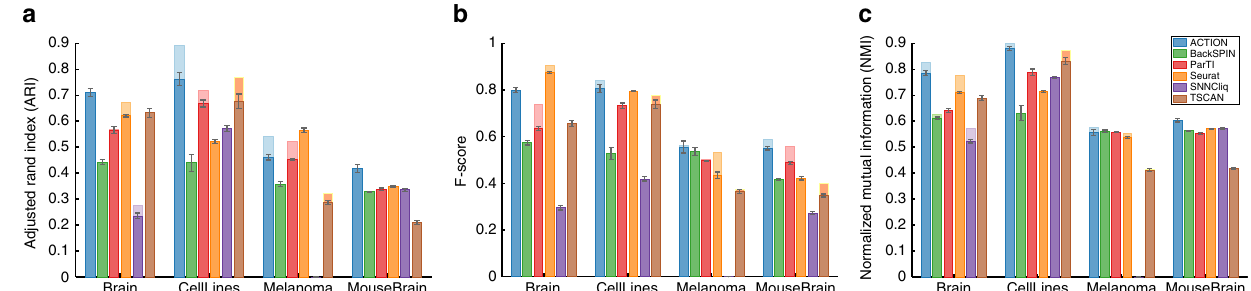
Fig. 5 Performance of ACTION in identifying discrete cell types. ACTION identi fi es cell types by classifying cells according to their dominant primary function (closest archetype). Performance is measured via various measures with respect to the cell types provided with the data: a Adjusted Rand Index (ARI), b F-score, and c Normalized Mutual Information (NMI) of cell-type identi fi cation. Larger values are better, and the perfect score (upper bound) is one. Lighter shades are the actual results when using all cells/ samples, whereas the darker bar and the error bar indicates the standard error in a 10-fold test to estimate the variability and stability of predictions for each method. In the CellLines dataset, which was originally created to benchmark cell-type identi fi cation methods, ACTION outperforms other methods with respect to ARI and NMI measures, and ties with Seurat in terms of F-score. In the MouseBrain dataset, ACTION signi fi cantly outperforms other methods in all three measures. In the Brain datasets there is a competition between ACTION and Seurat, whereas in the Melanoma there is more variability among different methods. This is particularly associated with the level of annotations in this dataset (lack of annotations for T-cell subclasses and tumor subtypes, for example) and the varying resolution of different